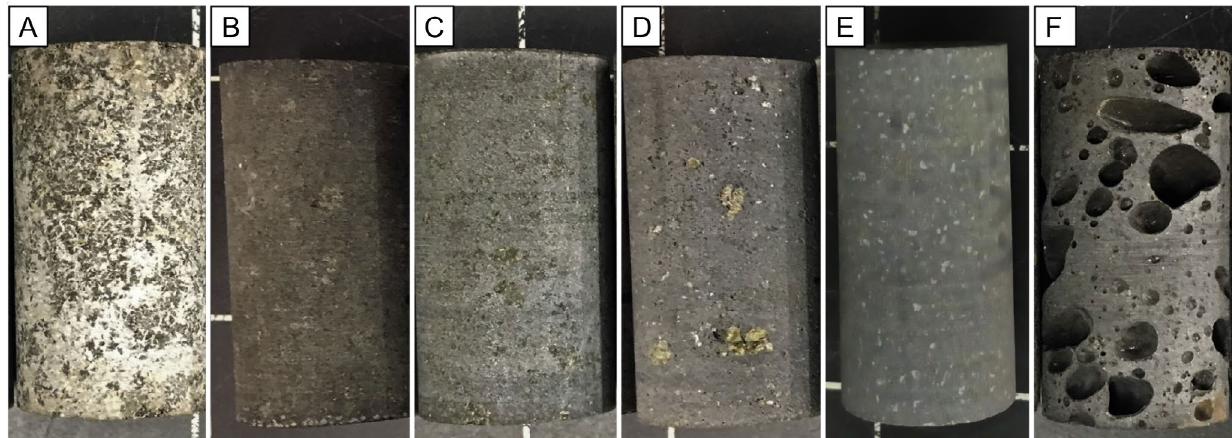
Figure 3: Photographs of representative cylinders (4.0 × 2.0 cm) from six La Réunion samples. [A]: medium grained gabbro (sample B06); [B] fine-grained dolerite (micro-troctolite B05); [C] dyke sample from Cilaos (PdN; sample D1); [D] dense lava with olivine phenocrysts (sample B02); [E] plagioclase-rich dense basalt (sample A03); [F] vesicular aphyric lava (sample